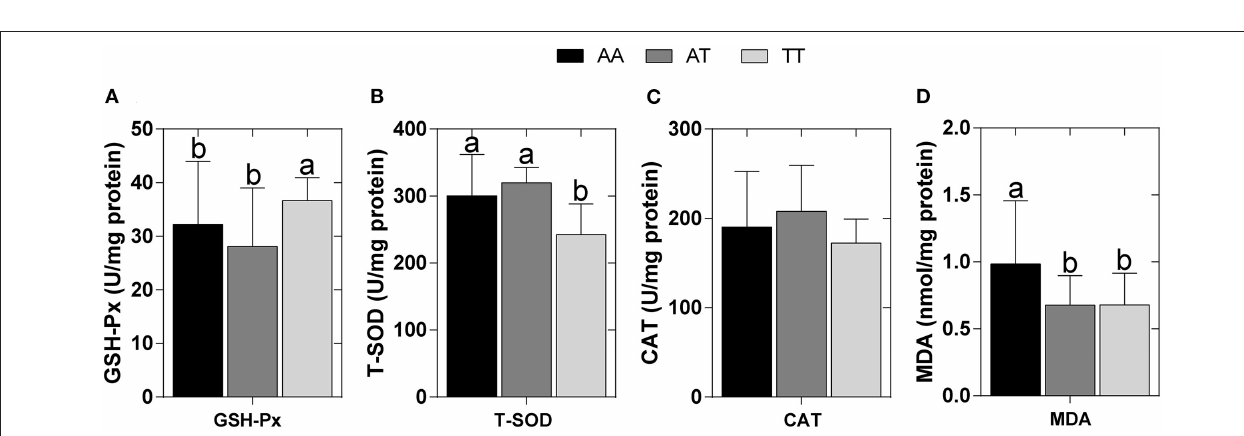
FIGURE 3 | Hepatic pathological scores (A) and TG levels (B) in different genotyped layers. TG, triglyceride; AA, AA genotype hens; AT, AT genotype hens; TT, TT genotype hens. Values are expressed as means ± standard deviation (SD); n = 9 hens with each genotype. a,b Means within a histogram with no common superscripts differ significantly ( P < 0.05).